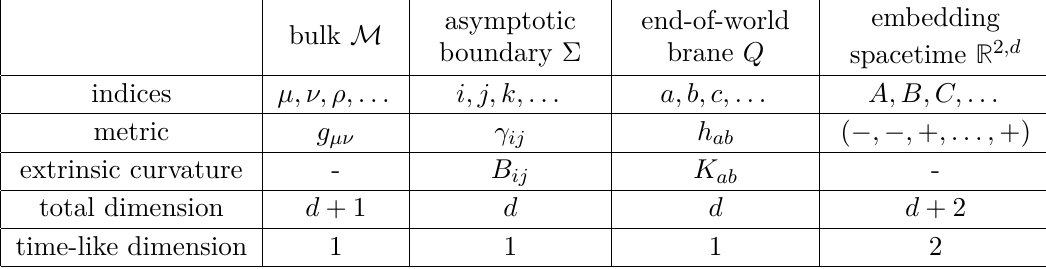
Table 1 . Notations for the manifolds considered in this